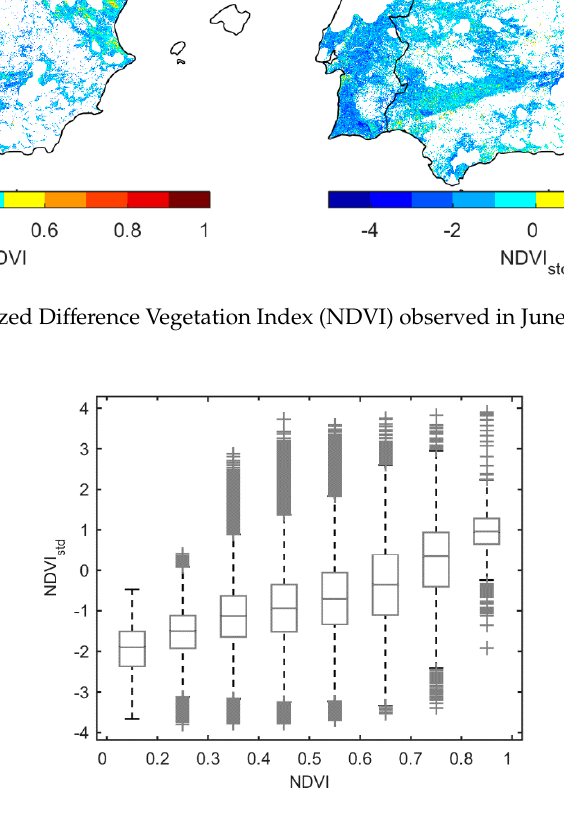
Figure 3. Boxplot of NDVI std values in June 2005, for each NDVI interval.